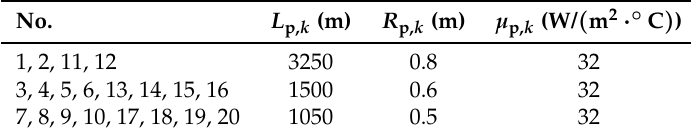
Table 2. Parameters of pipelines.